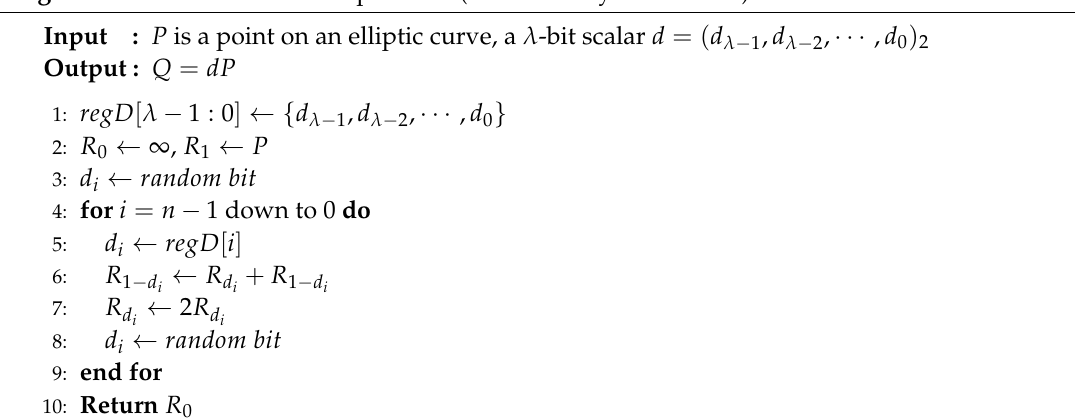
Algorithm 1: ECC Scalar Multiplication (initialized by random